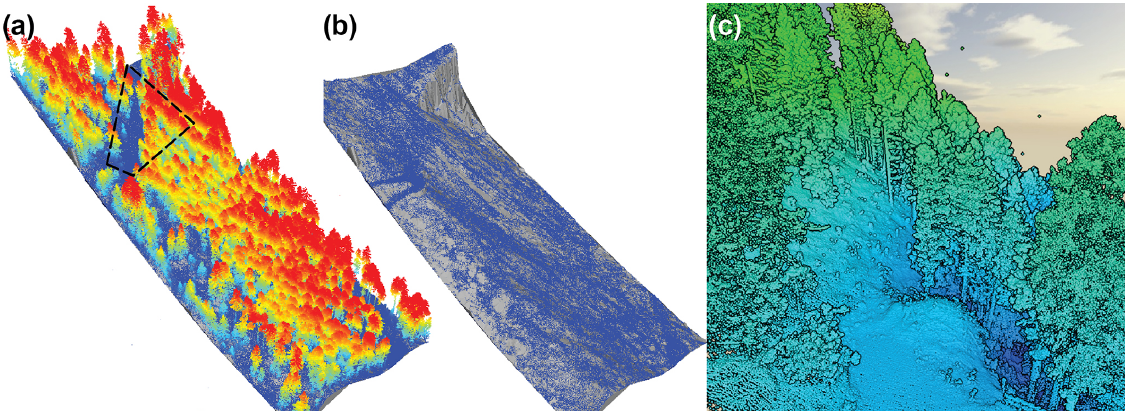
Figure 2. (a) The acquired lidar point cloud colored according to the height above ground (blue is 0m, red ≥ 23m). (b) LAStools post- processed ground points used to generate a high-resolution digital surface model for the rockfall simulations. (c) Zoomed-in section of the cleared area as indicated in (a) . The mesoscale surface roughness is clearly discernible in the ground points in the cleared area as well as below the remaining tree